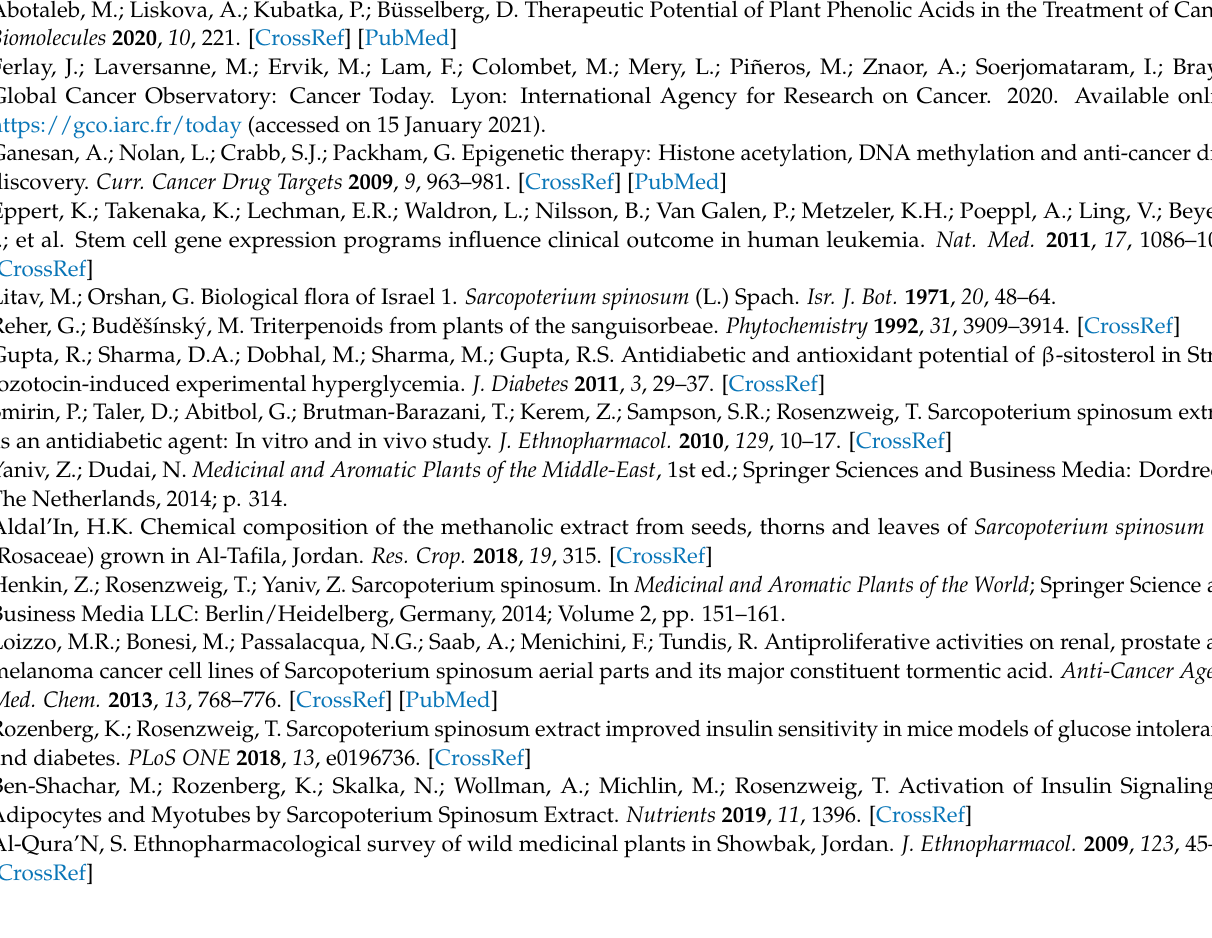
Supplementary Materials: MS spectroscopic analysis of stachydrine as hydroiodide (Table S1), its